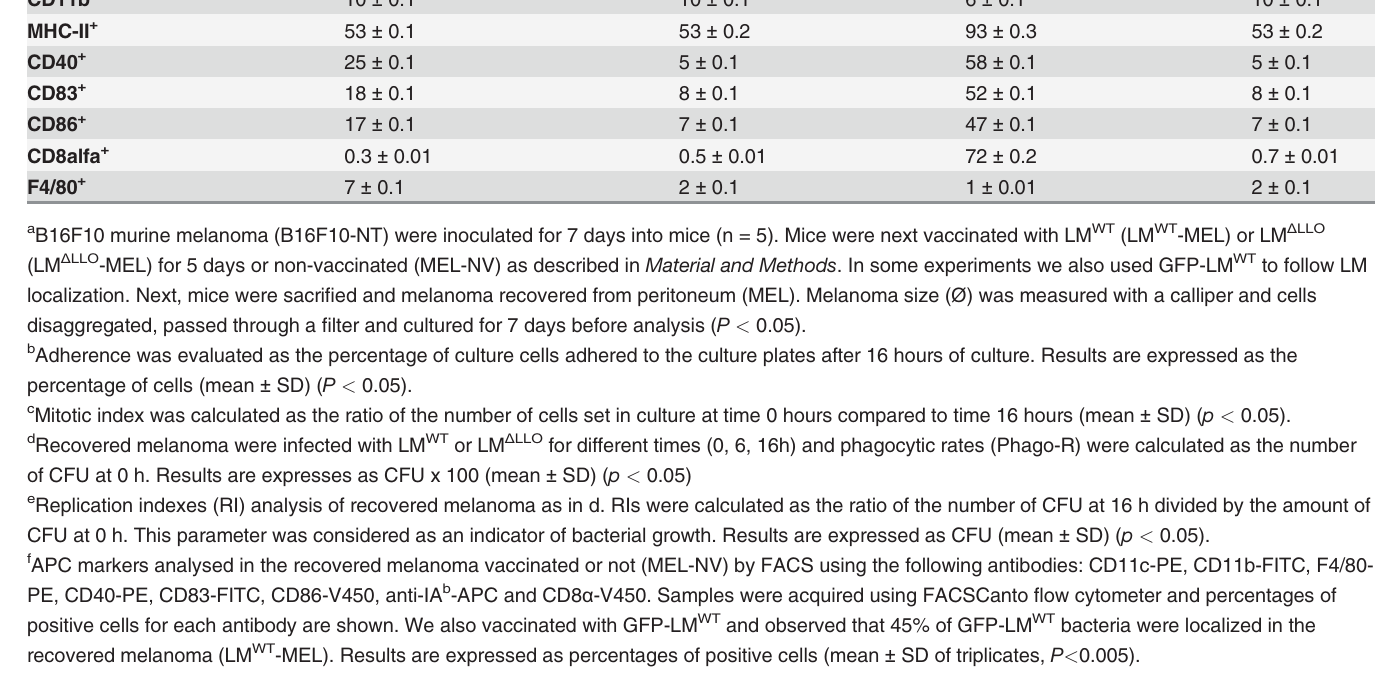
CD11b + F4/80 + positive macrophages (data not shown) and NK cells of the tumorigenic CD49b + phenotype (black bars of Fig. 3A in left graphic). Third, we detected 200-fold increases in the levels of MCP-1, TNF-alfa, IFN-gamma and IL-12, cytokines produced after melanoma therapy with LM WT (black bars in Fig. 3B) compared to non-treated mice (white bars in Fig. 3B). Melanoma therapy with LM WT also altered T cell responses, increasing the percent- ages of CD8 + T cells and decreasing in the percentages of CD4 + T cells (CD4 and CD8 black bars on left plot of Fig. 3A). The percentages of CD4 and CD8 T cells detected after melanoma therapy with LM WT were similar to the percentages observed after a classical LM WT infection, suggesting that T cells were Listeria driven (Fig. 3A). We next examined LLO specific T cell re- sponses induced by melanoma therapy with LM WT since LLO seemed relevant in this melano- ma model and in most reported Listeria -based immune-therapies [4, 5, 15, 24]. Therapy of melanoma with LM WT stimulated higher 1.79 ± 0.03 percentages of recombinant LLO (LLO )-specific CD8 + cells and IFN-gamma producers and lower 0.4 ± 0.01 percentages of rec